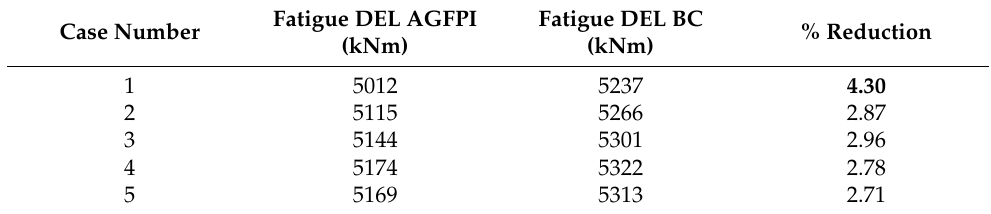
Table 6. Controller performance regarding the blade out-of-plane bending moment (fatigue DEL). Case